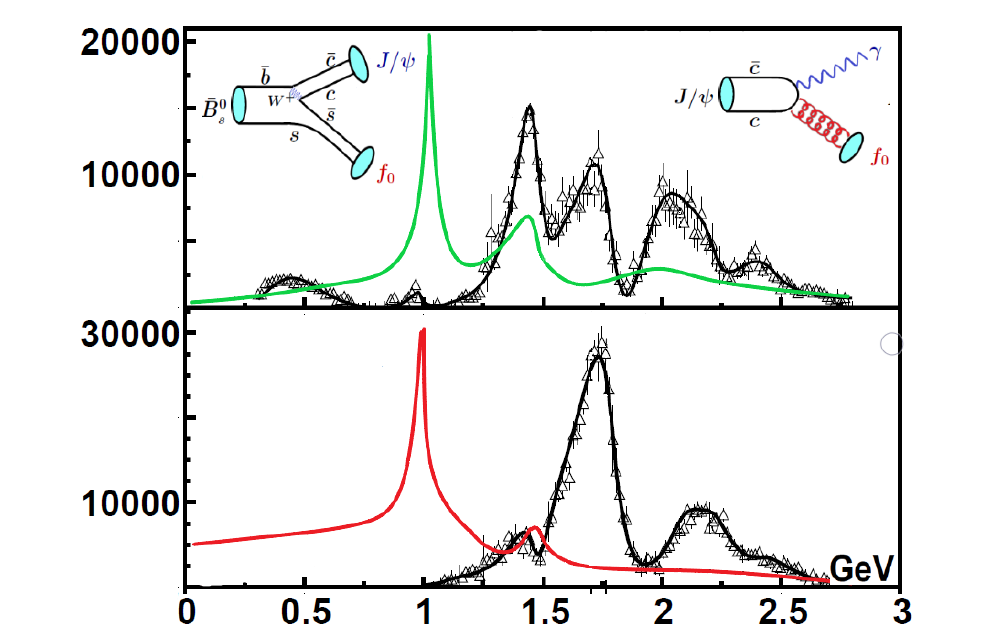
K and pion and kaon form factor s s